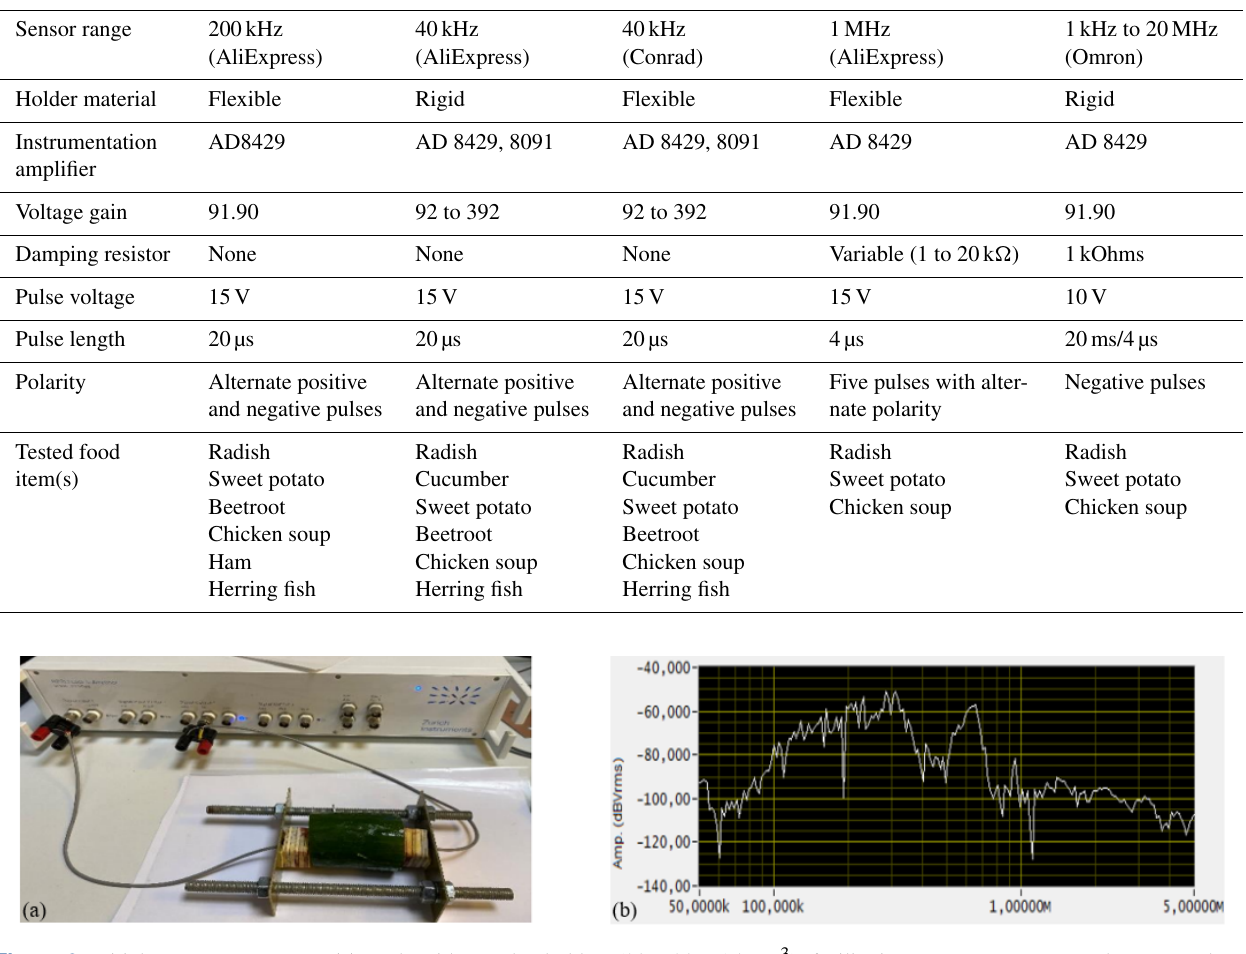
Figure 3. Initial measurement setup (a) made with wooden holders (20 × 20 × 15mm 3 ), facilitating a space to accommodate a sample of dimension 10cm in length and 8cm in width, and (b) the change in amplitude versus frequency response for a cucumber of length 6cm using a lock-in amplifier.